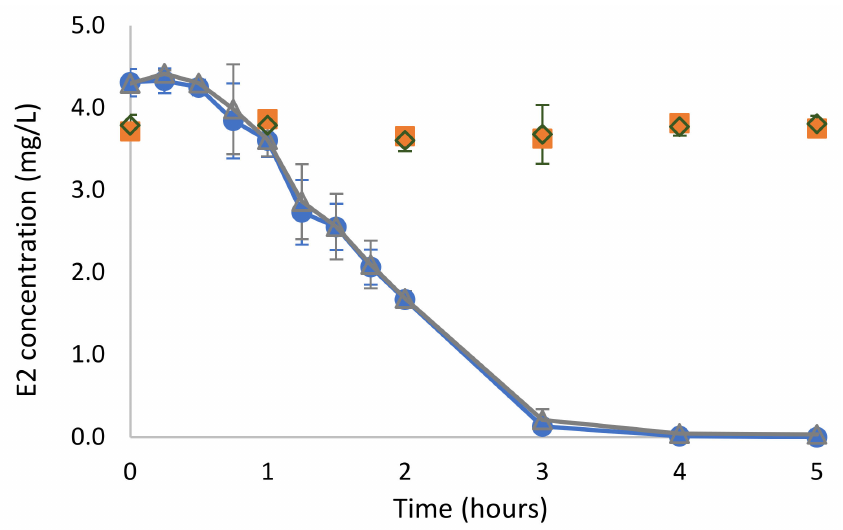
Figure 2. Biodegradation of E2 (5 mg/L) by Rhodococcus sp. ED 55 in the synthetic mineral medium as sole carbon source ( • ), with supplementation of sodium acetate ( ∆ ), adsorption control ( ♦ )